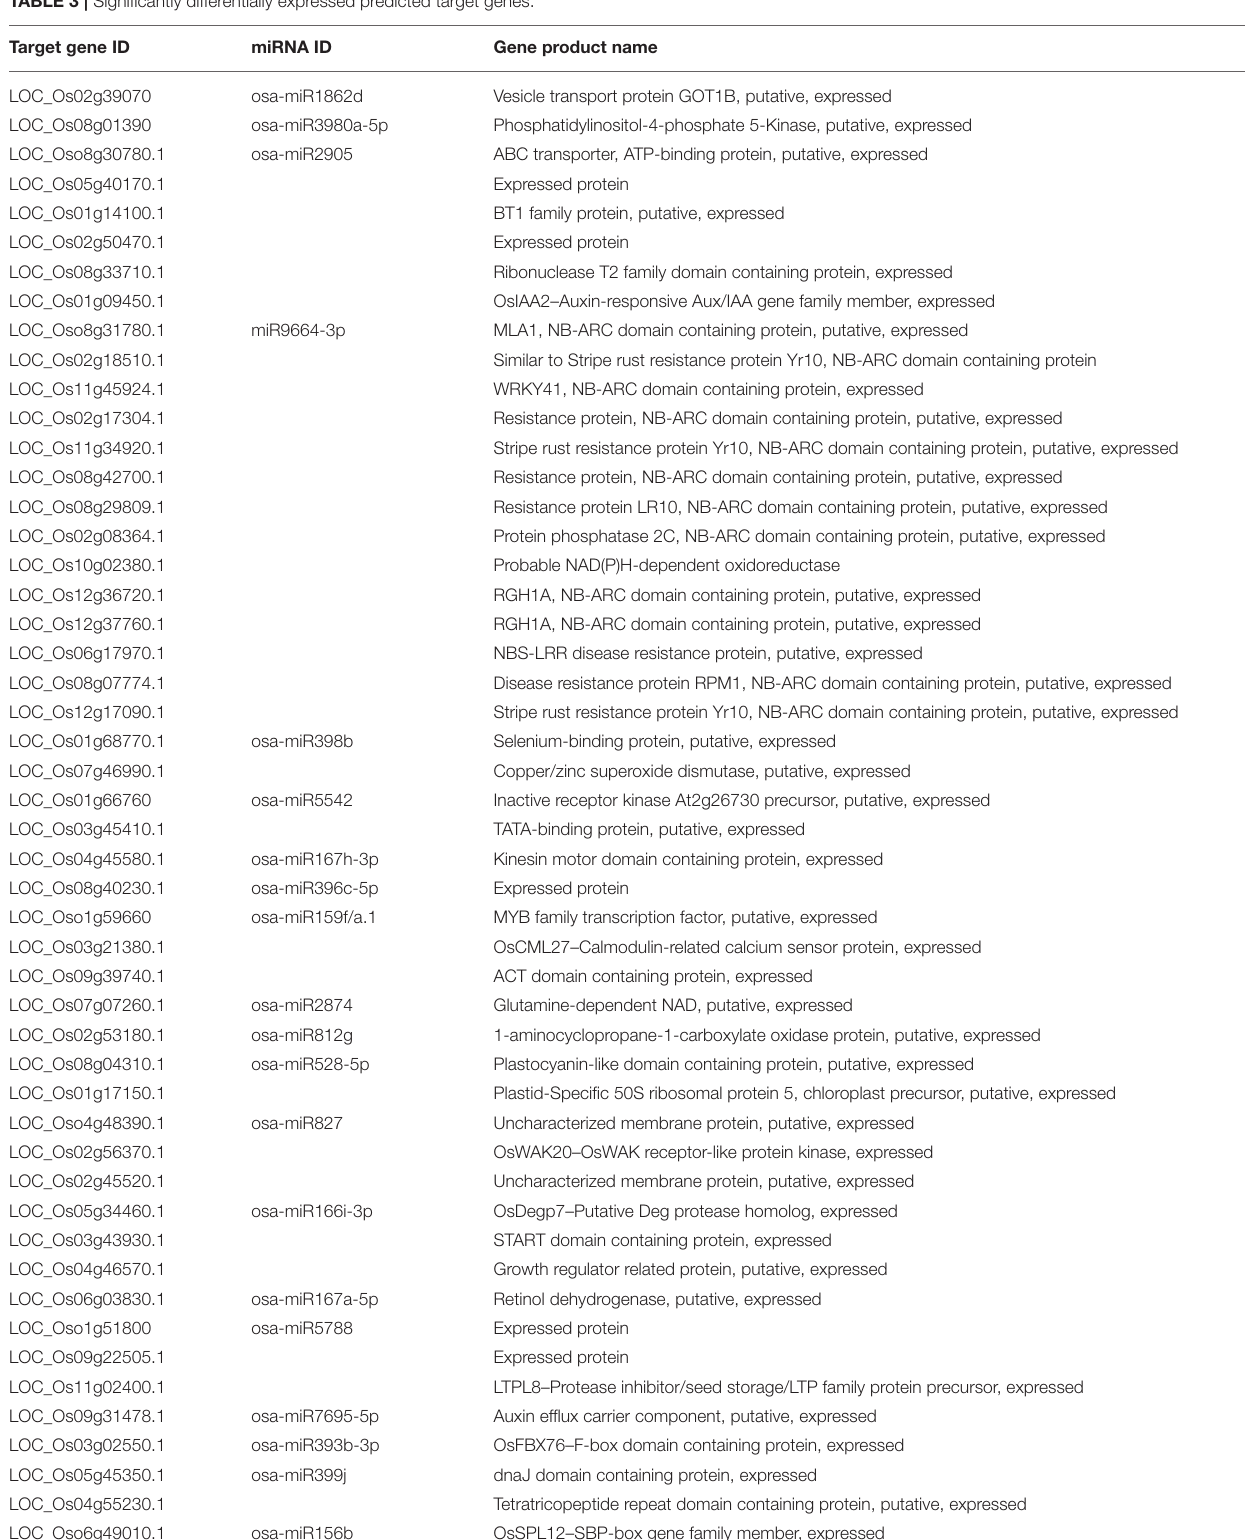
TABLE 3 | Significantly differentially expressed predicted target genes. Target gene